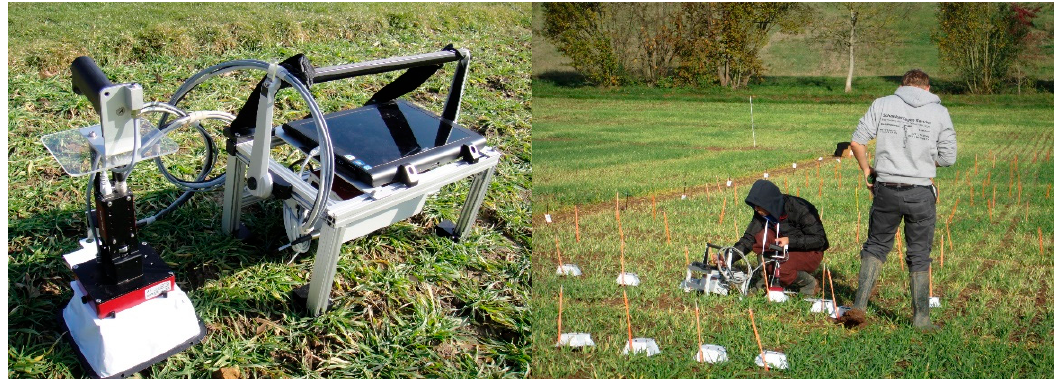
Figure 1. The mobile chlorophyll fluorescence sensor Weed-PAM. ( Left ): the sensor’s setup, including a camera head, a dark adaption box, a control unit with battery inside, a tablet computer and the essential cables for data communication and power supply. ( Right ): Herbicide resistance identification with the sensor in the field.